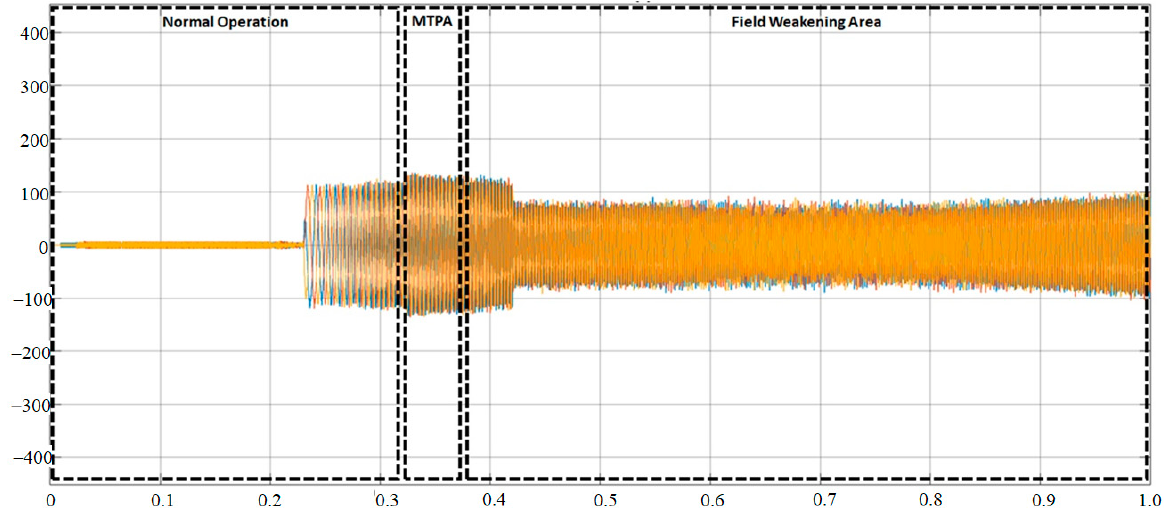
Figure 11. Torque output of the IPMSM using the proposed lookup table-based controller.